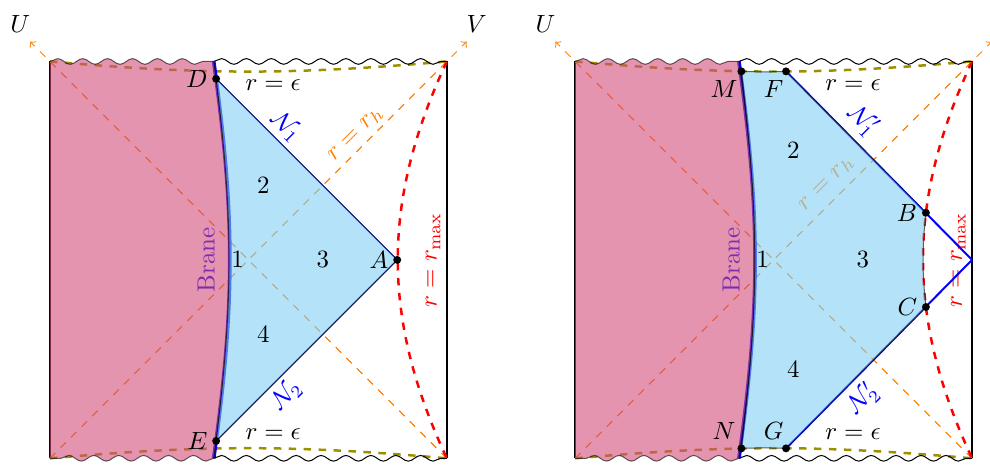
Figure 5 . WDW patches for T > 0 and r h > LTr max in the left) (cid:12)rst regularization and right) second regularization. Note that, in the (cid:12)rst regularization the null boundaries are ended on the ETW brane. This case happens when the tension T of the ETW brane is small enough, and the UV cuto(cid:11) at r max is not very close to the asymptotic boundary of the bulk spacetime. However, if in the left diagram r max , then the null boundaries cannot terminate at the ETW brane. In ! 1 this case, the correct WDW patch is given by the left side of (cid:12)gure 4.